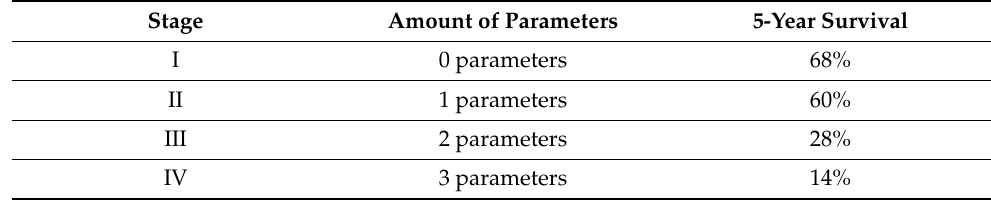
Table 3. Stages of cardiac involvement in AL amyloidosis [74].